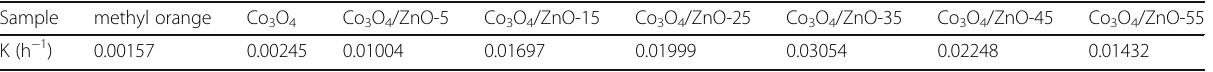
Table 3 First-order rate constants of pure Co 3 O 4 nanoparticles and Co 3 O 4 /ZnO heterostructures